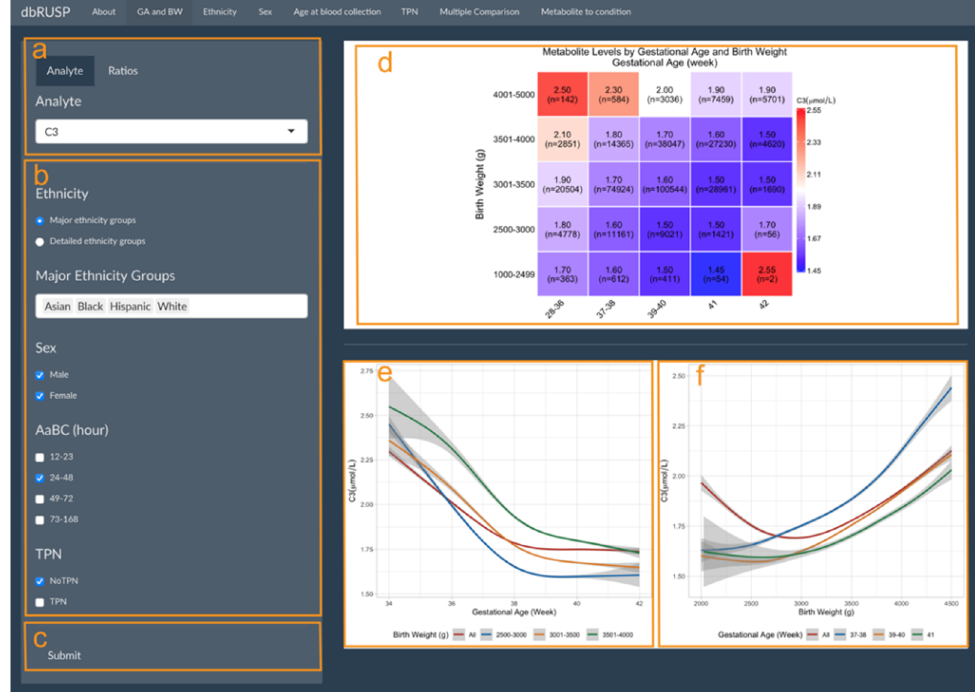
Figure 1. Metabolite levels by gestational age and birth weight. Module 1 panels are provided to select ( a ) metabolic analyte(s) or ratios, ( b ) covariates, and ( c ) submit criteria for analysis. ( d ) Heatmap of median C3 levels ( μ mol/L) in different GA (in weeks) and BW (in g) groups with the cohort size ( n =) shown for each group. Smoothed lines display the correlation between ( e ) C3 and GA for all newborns and for newborns in the three BW groups and ( f ) C3 and BW for all newborns and for newborns in the three GA groups. Grey areas show the 95% confidence interval (CI) of the estimation.